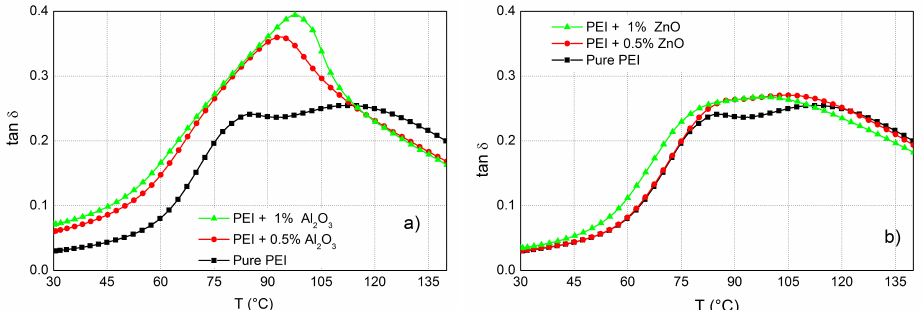
Figure 3. Temperature dependence of DMA development of pure PEI and its mixtures with Al 2 O 3 ( a ) and ZnO ( b )